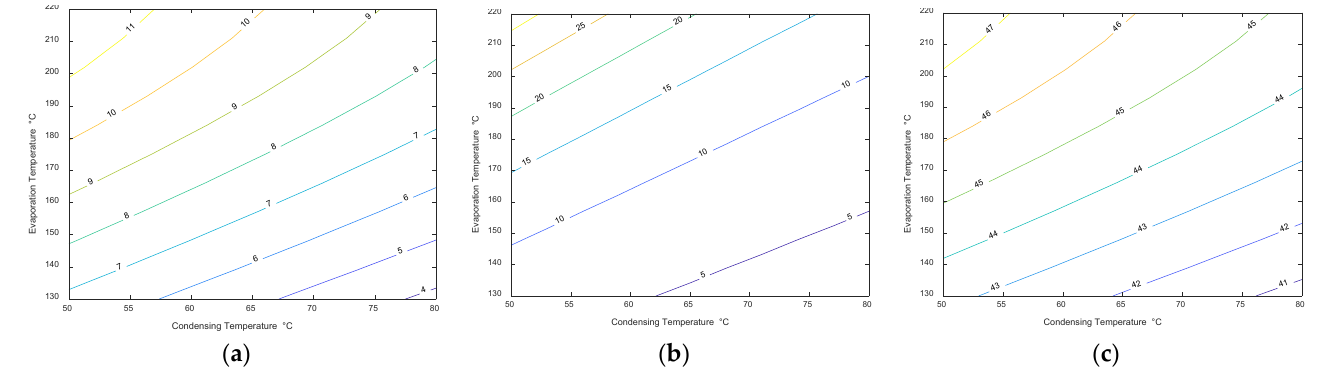
Figure 6. Parametric study: ( a ) ORC power; ( b ) ORC pressure ratio; ( c ) Combined cycle efficiency. Table 3. Cyclopentane specifications as ORC working fluid (Reprinted with permission from [7].).